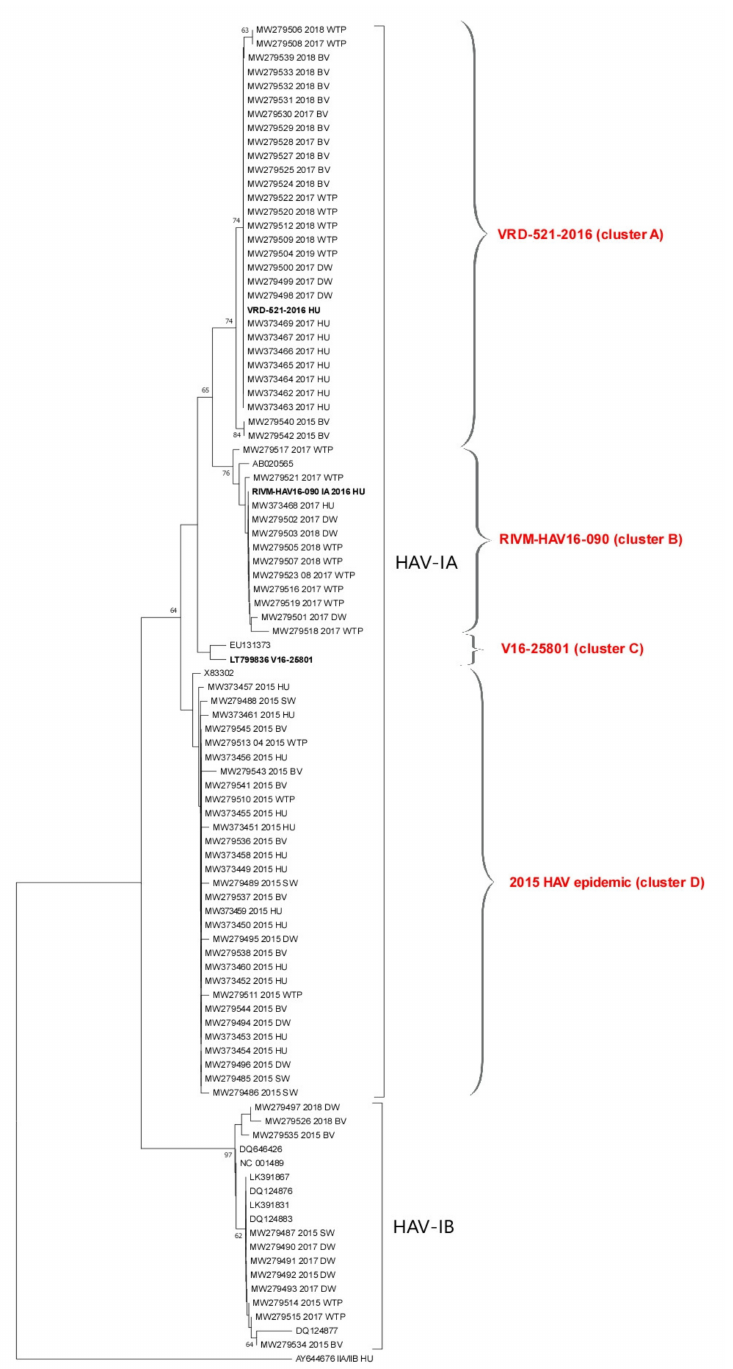
Figure 2. Phylogenetic tree of the hepatitis A virus VP1-2A region. The evolutionary history was inferred using the Neighbor-Joining method. The percentage of replicate trees in which the associated taxa clustered together in the bootstrap test (1000 replicates) is shown next to the branches (only bootstrap > 60% are shown). The tree is drawn to scale, with branch lengths in the same units as those of the evolutionary distances used to infer the phylogenetic tree. The evolutionary distances were computed using the Maximum Composite Likelihood method and are in the units of the number of base substitutions per site. This analysis involved 96 nucleotide sequences. There was a total of 197 positions in the final dataset. Analyses were conducted in MEGA